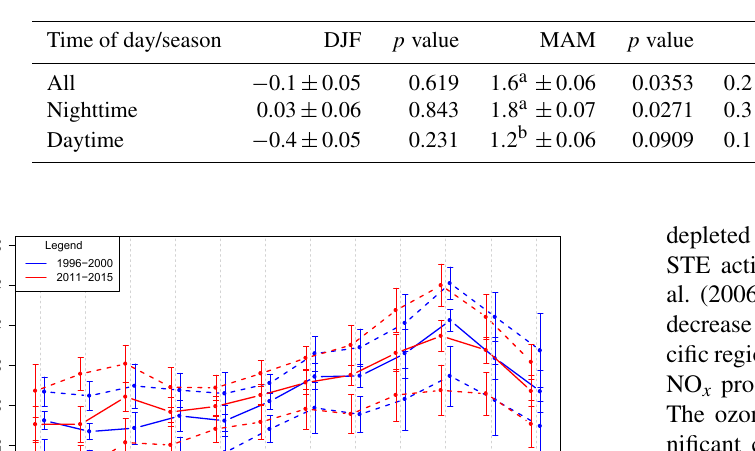
Table 1. Seasonal linear trends of ozone (ppbdecade − 1 ) at TLL for (a) all-day data (00:00–24:00UTC), (b) nighttime data from 22:00 to 04:00, and (c) daytime data from 11:00 to 17:00. Significant trends are labeled with a (95%) or b (90%), and standard error is shown as ± .